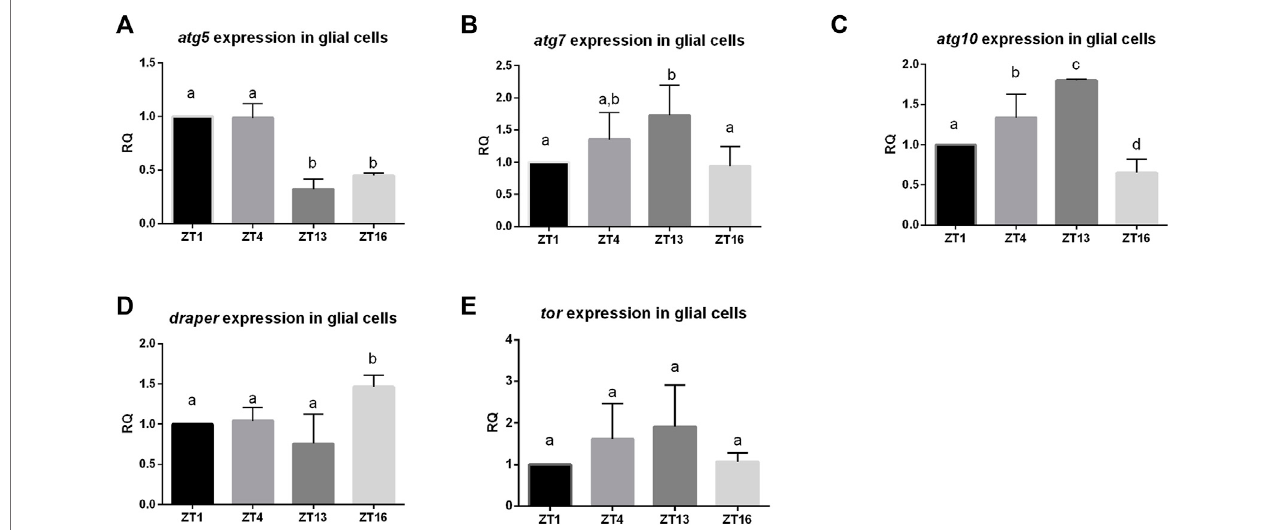
FIGURE1 | Daily pattern ofexpression ofgenesinvolved in autophagy in glia. Glia cells were sorted outat selected time points (ZT1,ZT4, ZT13, ZT16). qPCR data were calculated as ΔΔ CT and normalized to ZT1 as 1. Statistically signi fi cant differences are marked as letters: different letters above two bars mean there is statistically signi fi cant difference. Genes analysed: (A) atg5 (B) atg7 , (C) atg10 (D) draper , (E) tor .